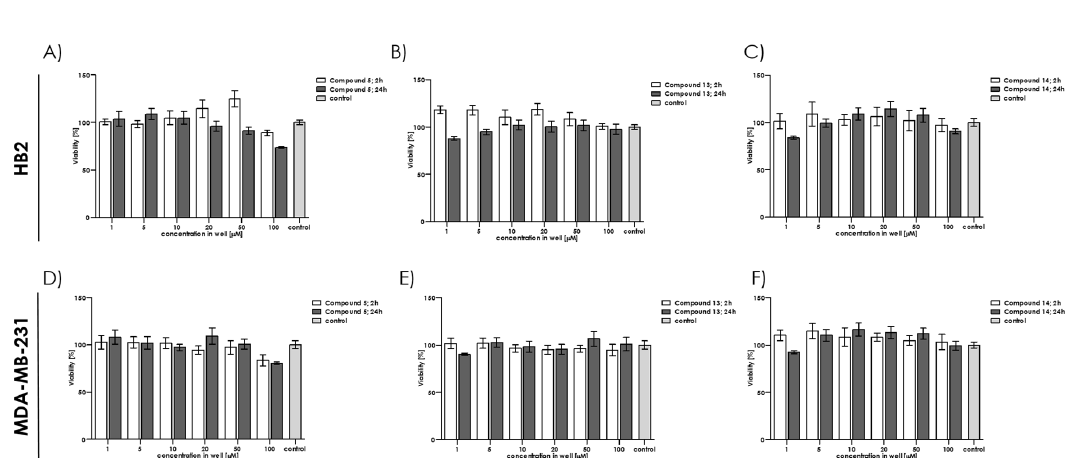
Figure 5S. CCK8 cytotoxicity assay performed for three compounds (5, 13, and 14). Two different cell lines were used: A) HB ‐ 2 and B) MDA ‐ MB ‐